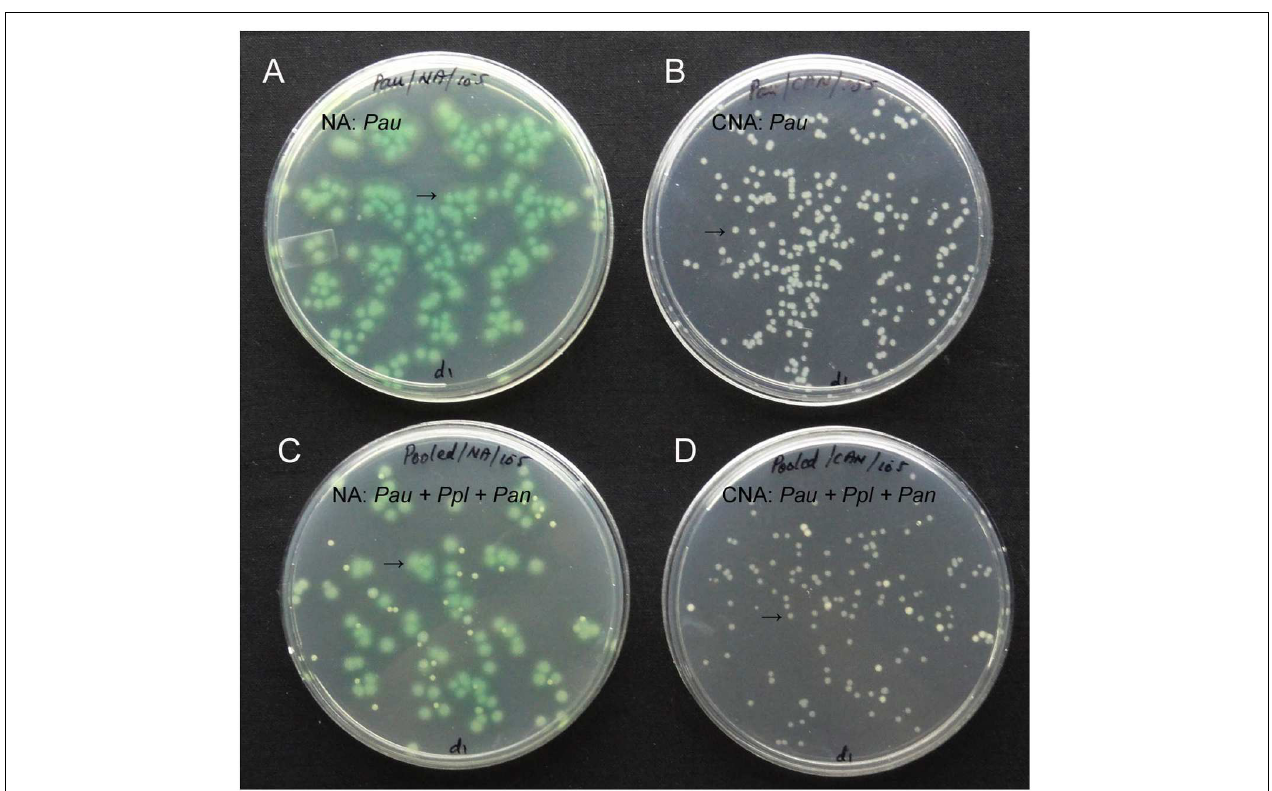
FIGURE 2 | Pure culture of P. aeruginosa ( Pau ) showing cfu at 10 5 of the 0.1 OD anchored stock as bluish-green tinged larger colonies on nutrient agar (NA, A) or as white distinct colonies on CNA (B), or a mix culture with P. plecoglossicida ( Ppl ) and Pantoea ananatis ( Pan ) showing clearly identifiable Pau colonies on NA (C) and CNA (D; Pau indicated by